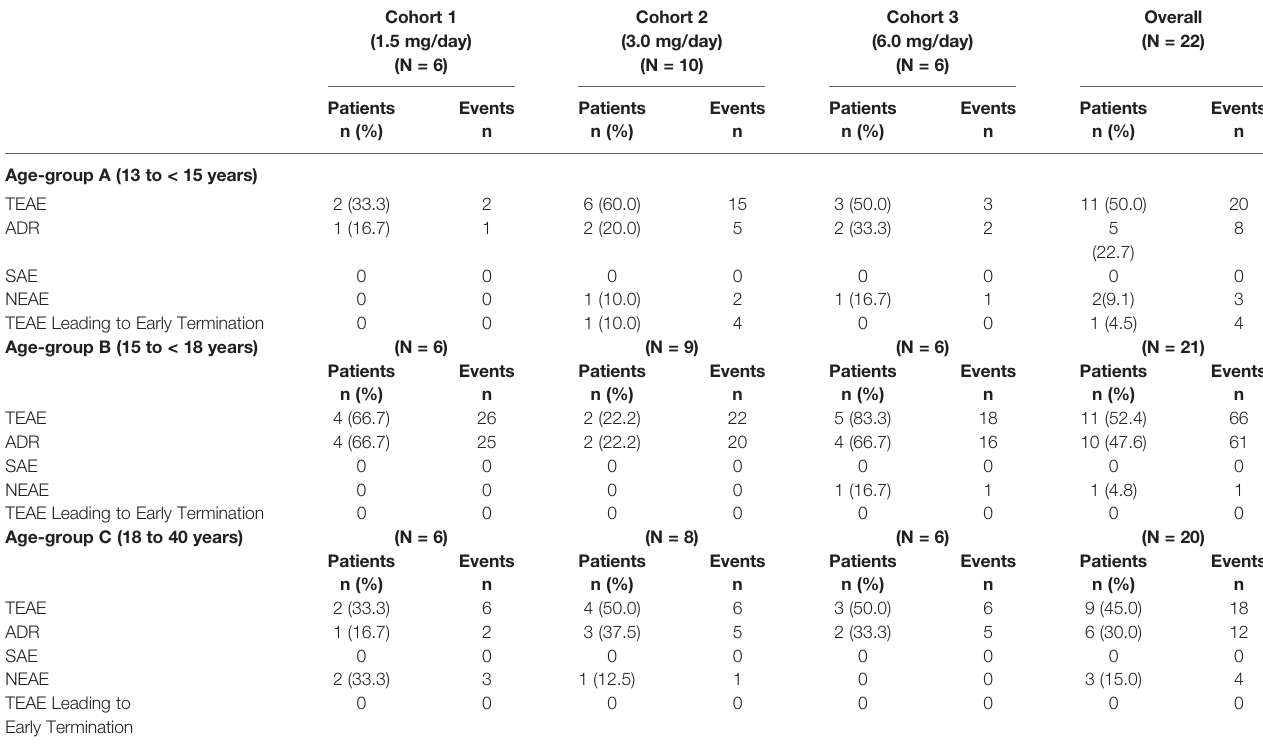
TABLE 3 | Overall summary of treatment-emergent adverse events (Safety Analysis Population).